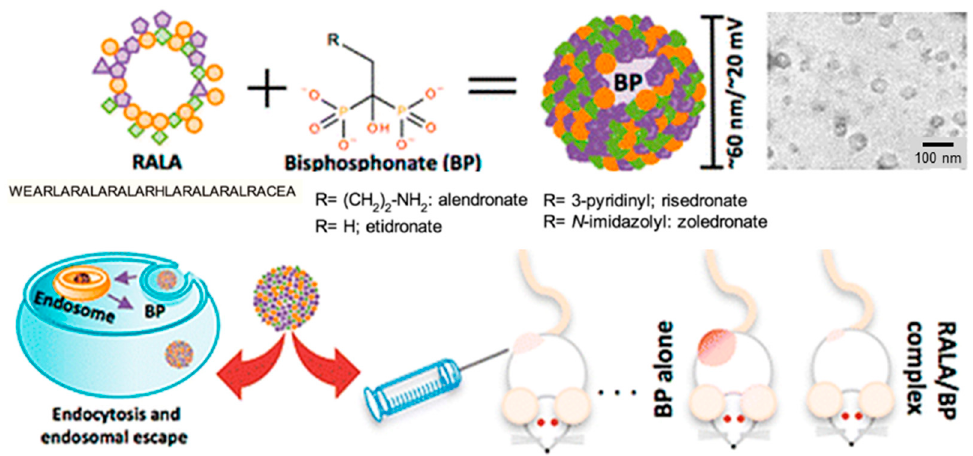
Figure 9. Nanoparticles with antitumoral properties based on self-assembled RALA peptides coated with BPs. Reproduced from [129].